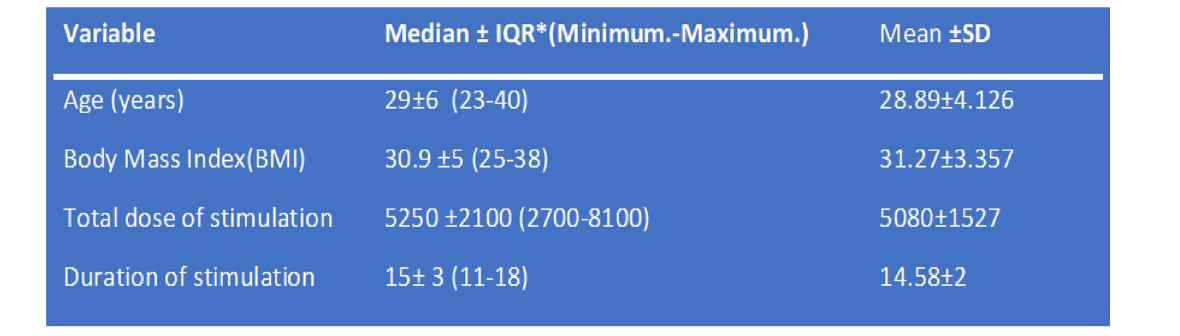
Table 1 The basal characteristics of the studied patients